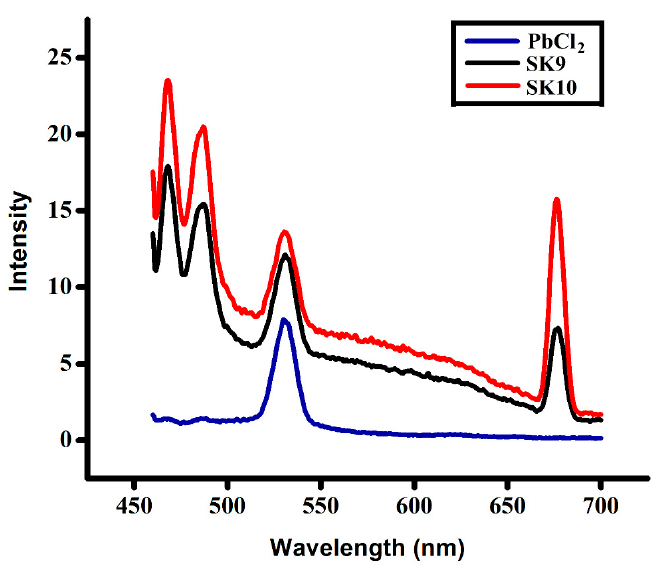
Figure 5. PL spectra of synthesized perovskites ( SK9-10 ).